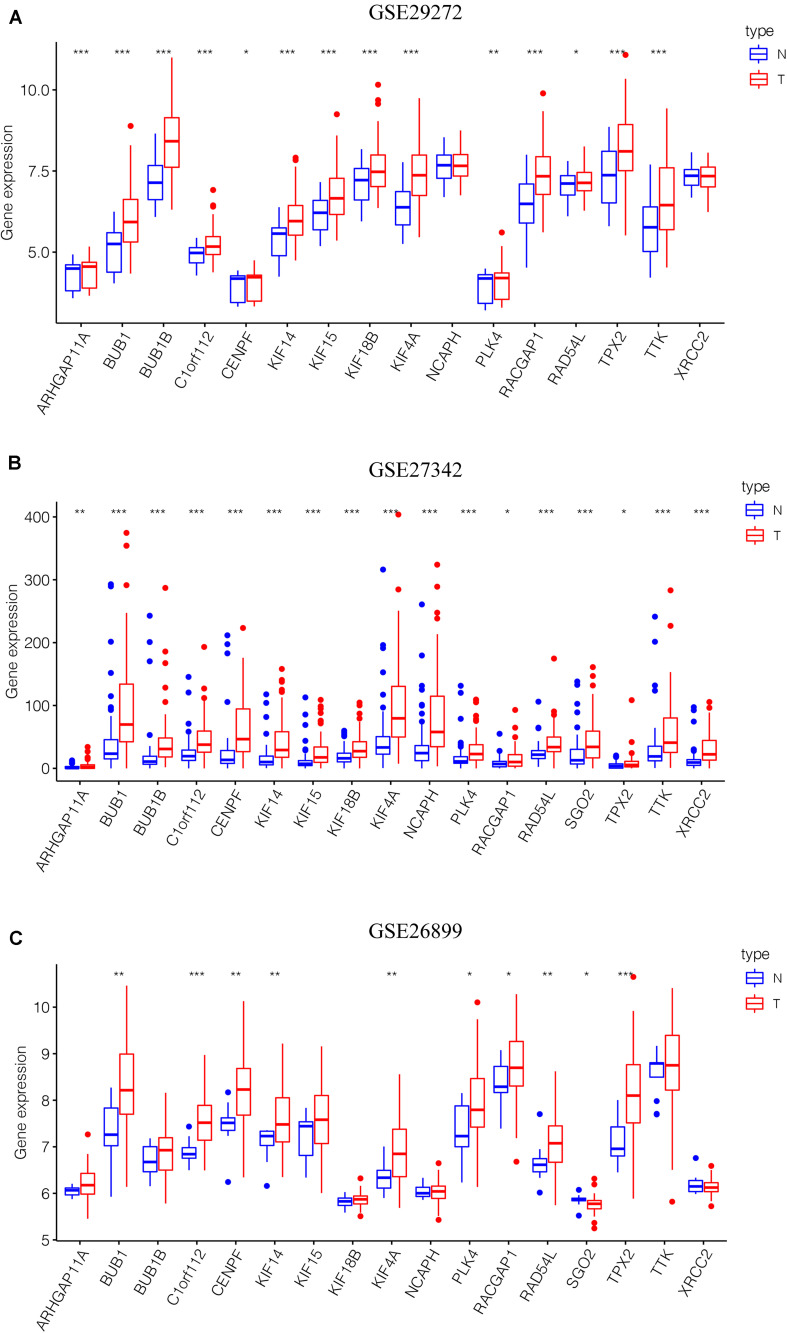
Validation of the key genes in the GEO microarray database. (A) GSE29272, 268 samples. (B) GSE27342, 160 samples. (C) GSE26899, 108 samples. *P < 0.05, **P < 0.01, *** P < 0.001. GEO, Gene Expression Omnibus.